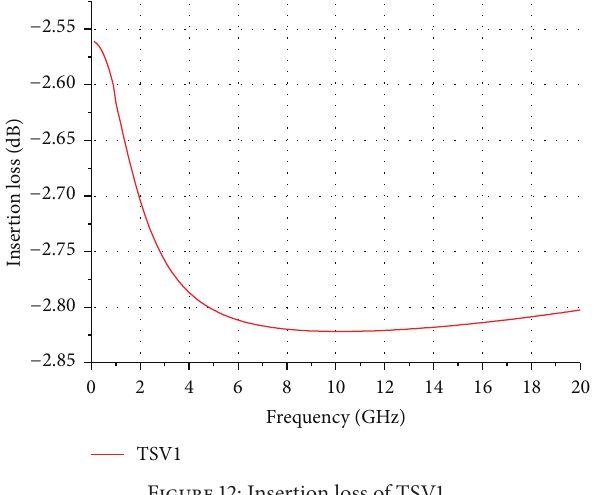
Figure 12: Insertion loss of